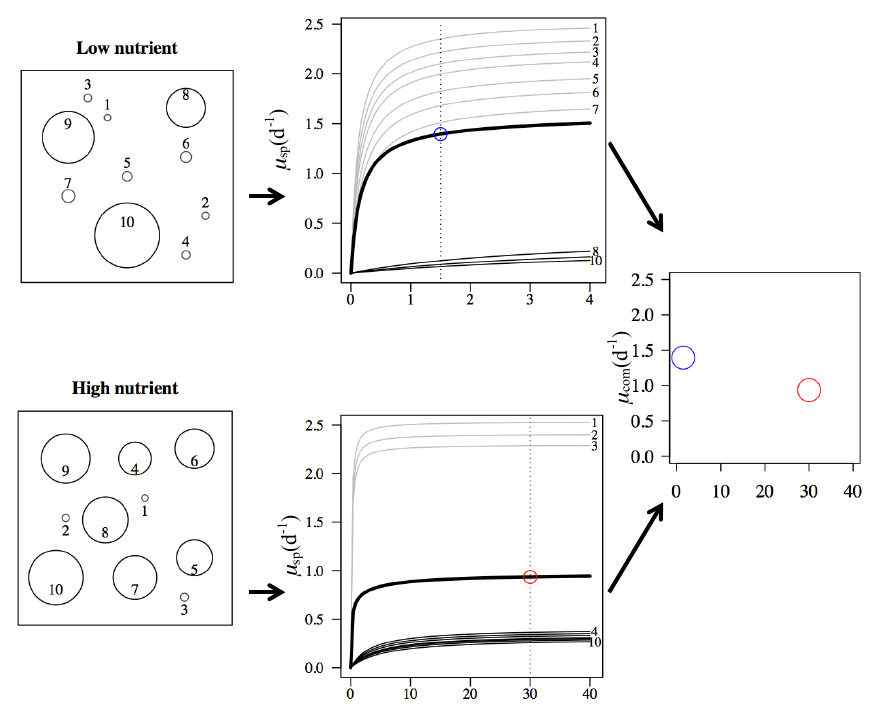
Figure 1. Conceptual diagram representing phytoplankton communities composed of small and large phytoplankton species (small grey and large black circles, respectively) in nutrient-limited and productive ecosystems. Each phytoplankton species composing their respective com- munities had its own growth rate response to nutrient concentration following a Monod kinetic. The growth rates for the whole community in both ecosystems have been evaluated by the mean of the cell-specific growth rates of each phytoplankton species composing their respective communities. At the bottom of the diagram, community growth rates for both ecosystems are represented at specific nutrient